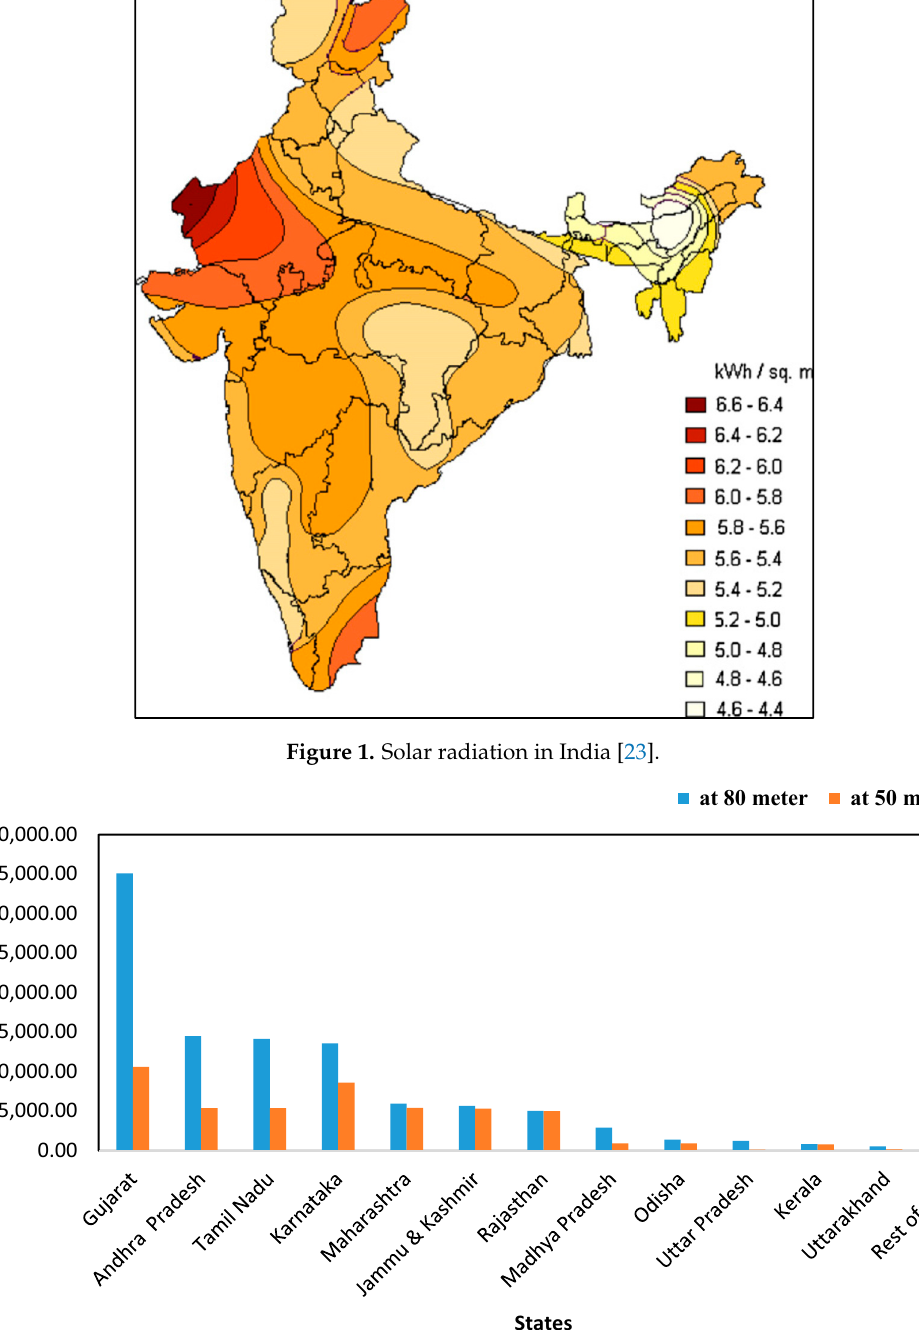
Figure 2. Wind potential in India [25].